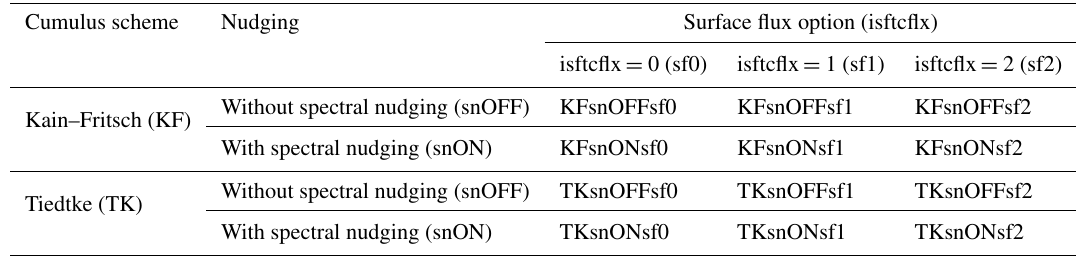
Table 2. Summary of the sensitivity experiments with the parameterizations